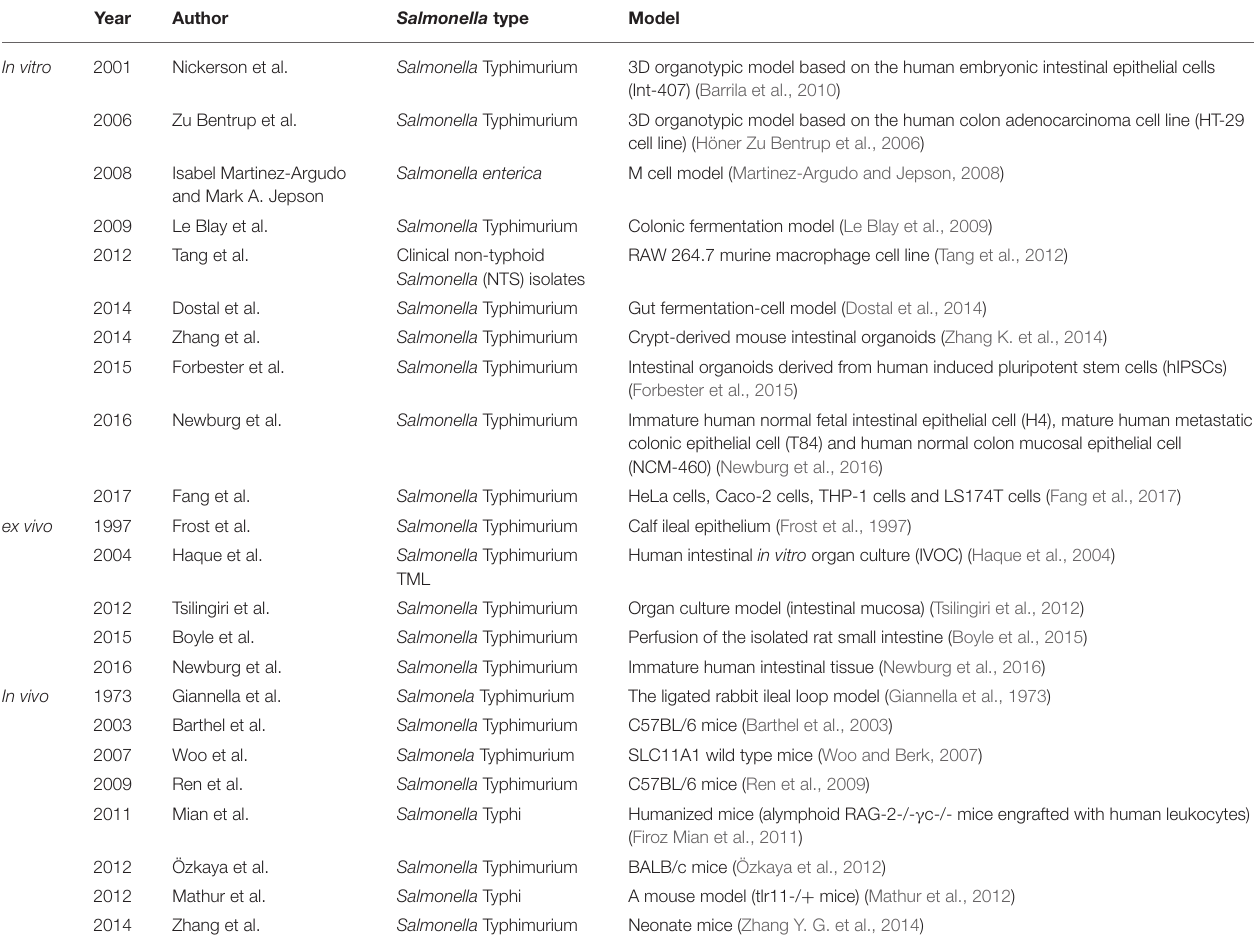
TABLE 1 | Salmonella infection